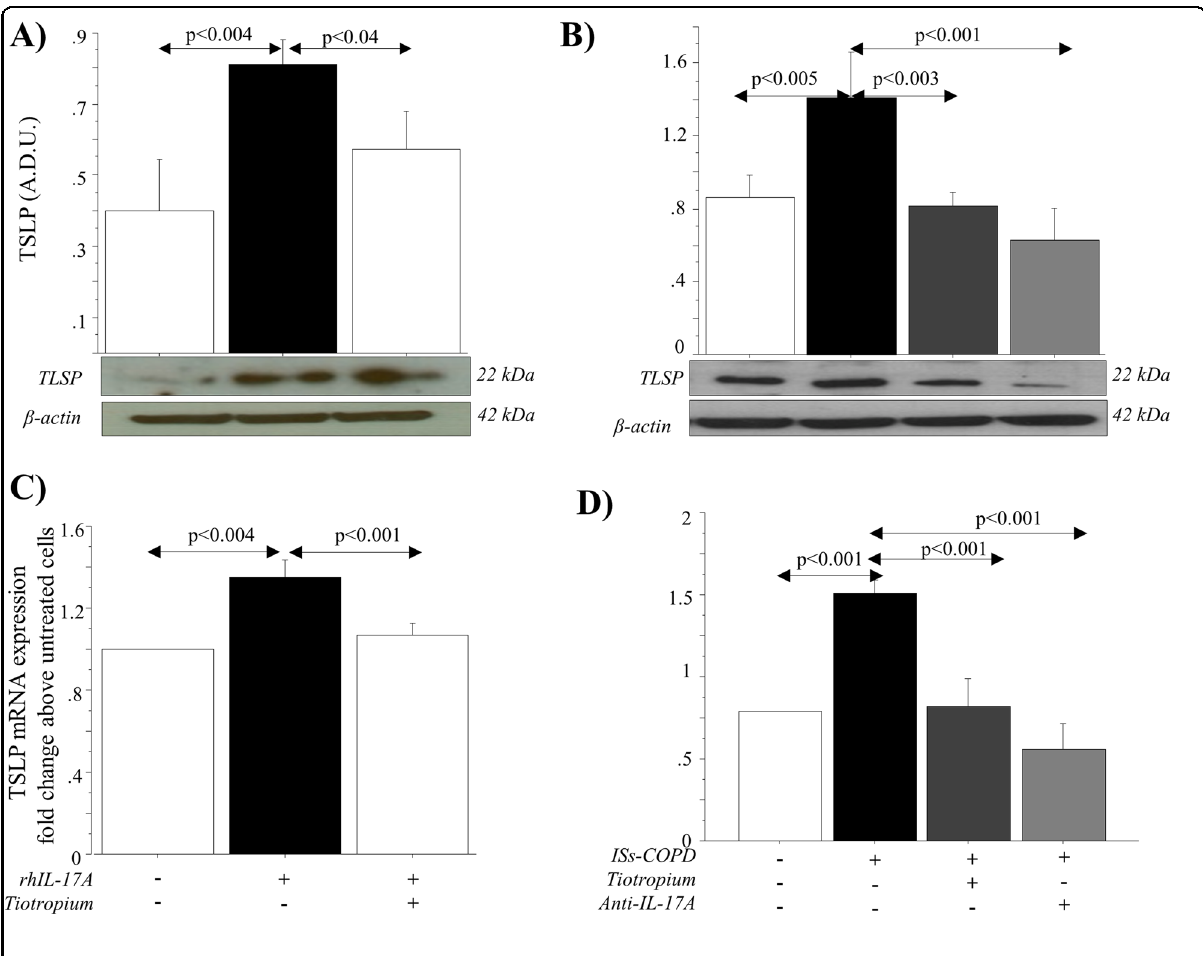
Fig. 4 Effect of anticholinergic drugs on TSLP production in NHBE cells stimulated with rhIL-17A or with ISs from COPD patients. NHBE cells, in the presence or absence of Tiotropium (100nM), were stimulated with rhIL-17A (20 ng/ml) ( n = 3) or with ISs from COPD patients untreated or treated with anti-IL-17A antibody ( n = 3) for each experimental condition). a and b show TSLP protein detected by western blot analysis as described in the “ Materials and methods ” section. Representative gel images of the experiments are shown. Bars represent the mean ± SD of arbitrary densitometric units (A.D.U.), normalized to β -actin used as the loading control. c and d show TSLP mRNA levels measured by real-time PCR as described in the “ Materials and Methods ” section and expressed as fold-change compared with untreated cells, chosen as the reference sample. ANOVA with Fisher ’ s test correction was used to analyze data. A p value < 0.05 was considered statistically signi fi